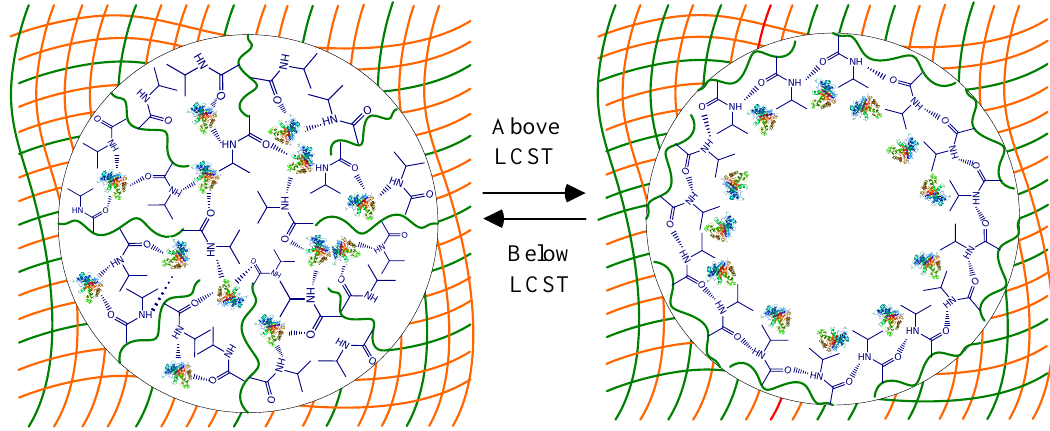
Figure 4. Closing and opening mechanism of the thermo-tunable pores of the NGHHs. Yellow and green lines represent the polymer chains of bovine skin gelatin and PNIPAAm, respectively.